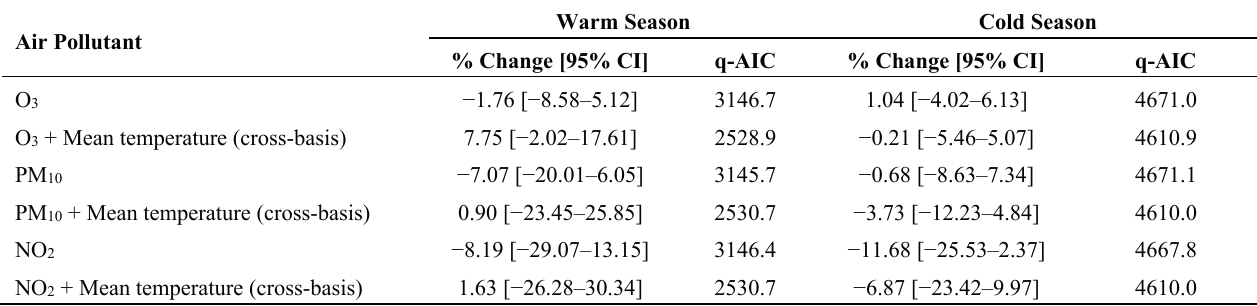
Table A2. Effect of air pollution levels (moving average of the last 7 days) on the risk of preterm birth by season, when the cross-basis term of mean temperature is included or not in the model, and the corresponding quasi-Akaike value (q-AIC). Effect reported in percent change per 10 µg/m 3 increase in air pollutant